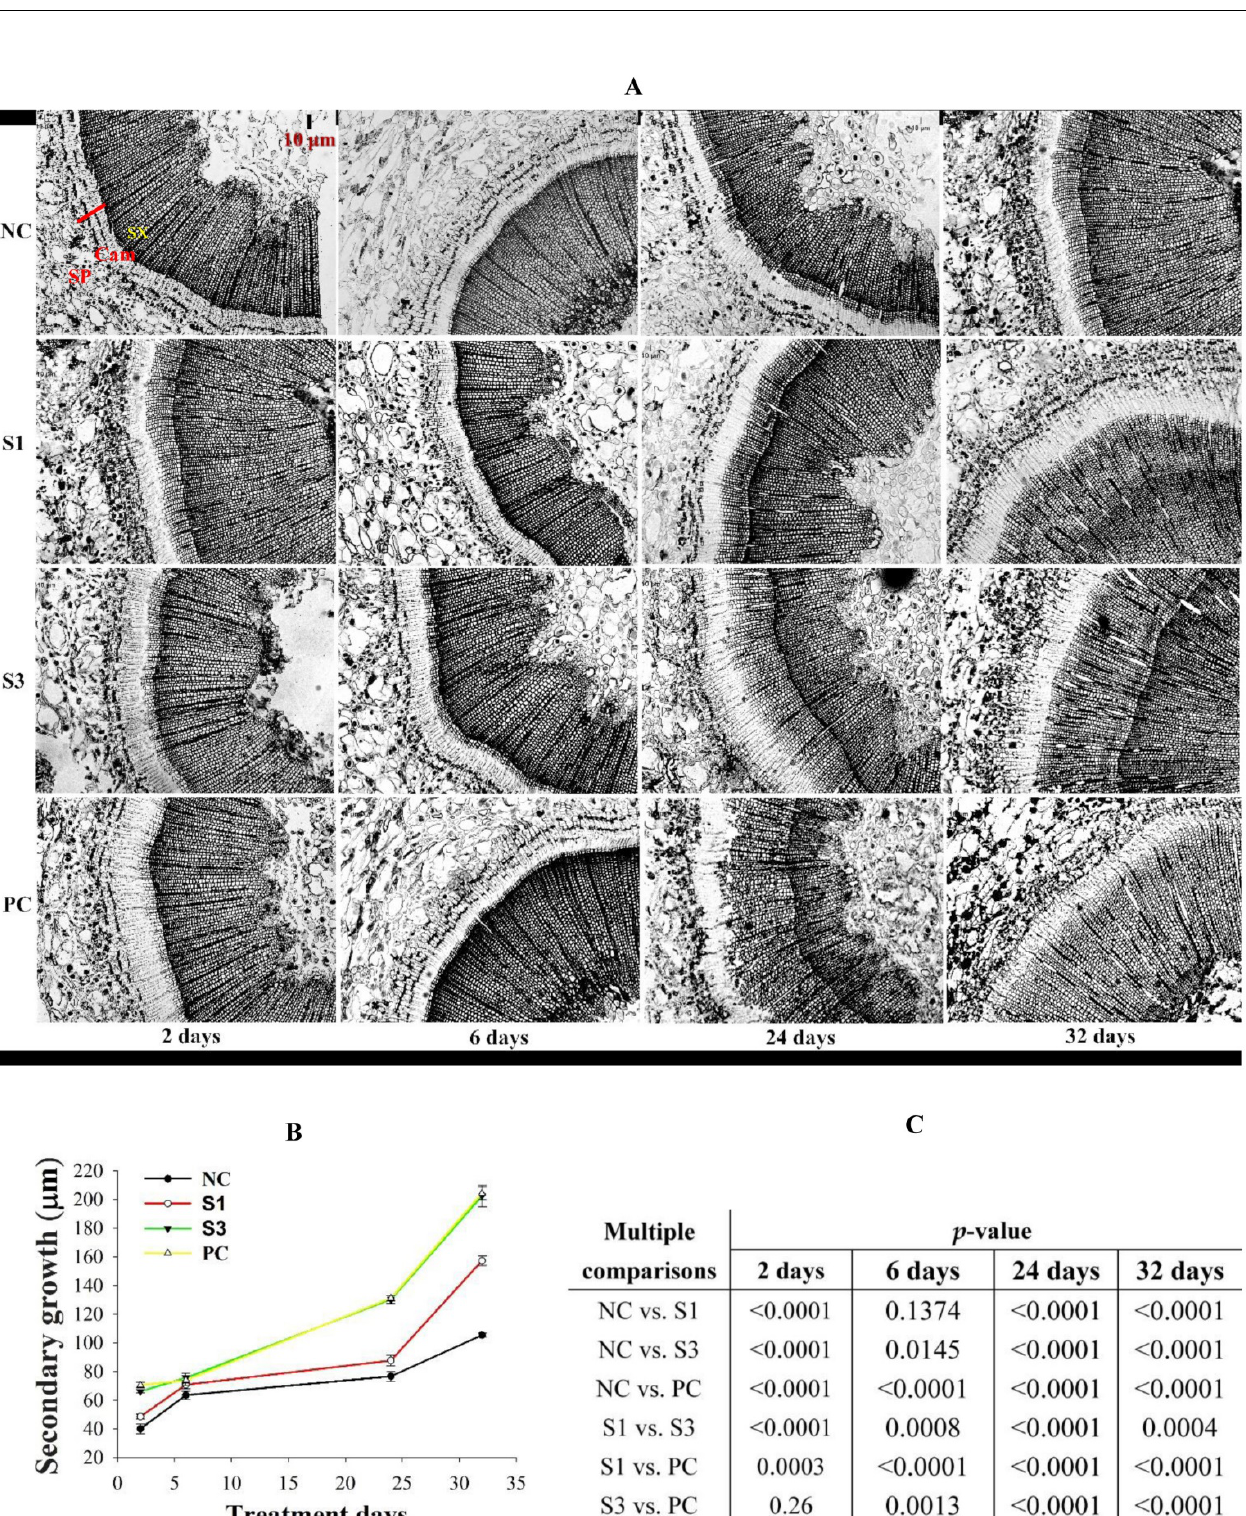
Figure 2. Exogenous IAA-induced changes in secondary growth in Chinese fir shoots. ( A ), Radial anatomical structures in shoots of different samples, in which the red arrow represented the radial thickening growth at specific treatment stages. The scale bar was 1:10 μm. SP, secondary phloem; Cam, cambium; SX, secondary xylem. ( B ), Patterns of secondary growth fluctuation in different samples, which was drawn according to the mean value ± SD of radial thickening growth measured from three different directions in the radial section. ( C ), Multiple comparisons of secondary growth among different treatment stages of shoot samples.